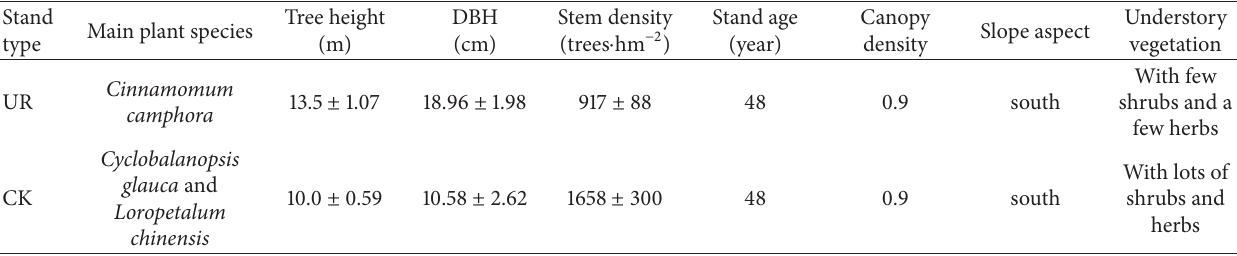
Table 1: General characteristics of experimental plots (mean ± SD, 𝑛 = 10).